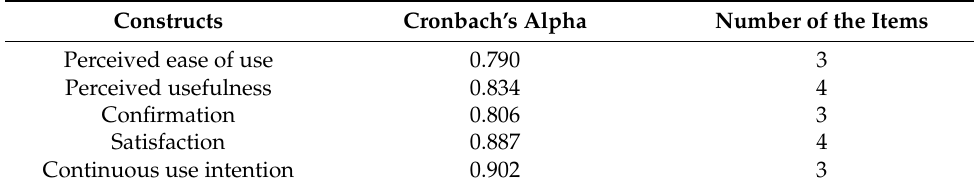
Table 3. Reliability